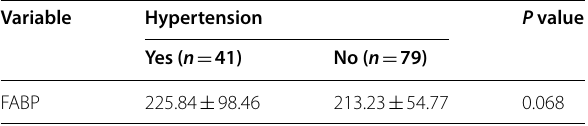
Table 2 Association